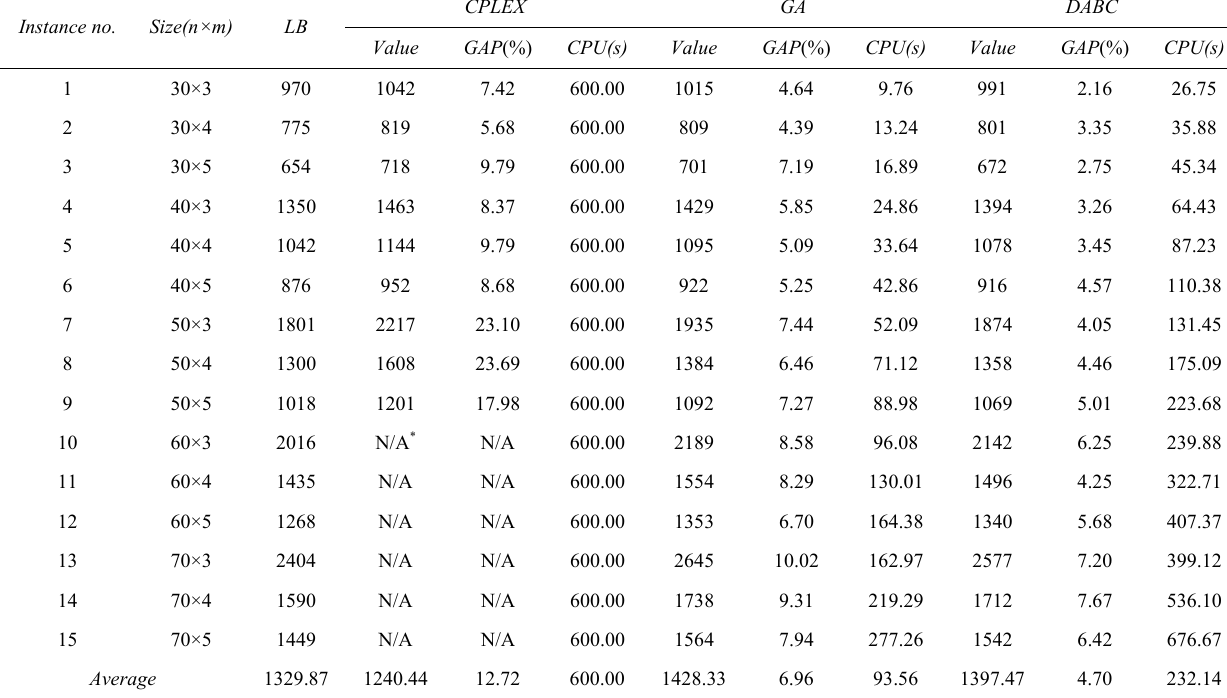
Table 5. Results of random instances with large